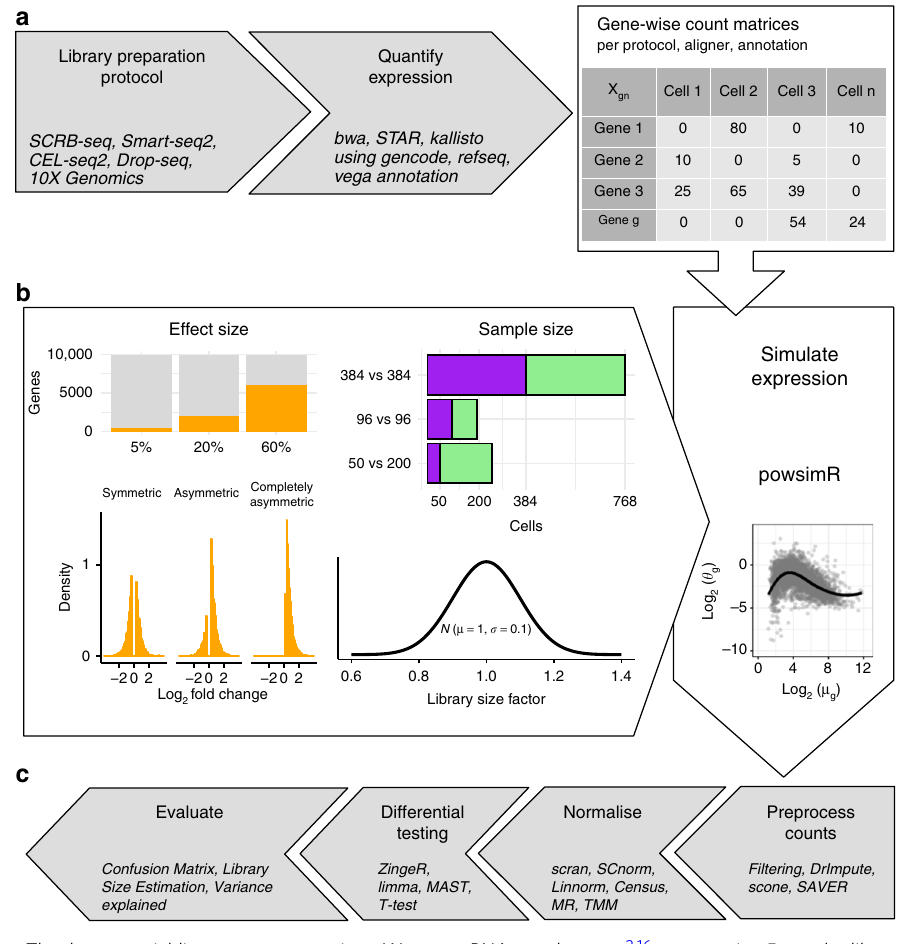
Fig. 1 Study Overview. a The data sets yielding raw count matrices: We use scRNA-seq data sets 2,16 representing 5 popular library preparation protocols. For each data set, we obtain multiple gene count matrices that result from various combinations of alignment methods and annotation schemes (see also Supplementary Figs. 1 and 2, and Supplementary Tables 1 and 2). b The simulation setup: Using powsimR 10 distribution estimates from real count matrices, we simulate the expression of 10,000 genes for two groups with 384 vs 384, 96 vs. 96 and 50 vs. 200 cells, where 5, 20 or 60% of genes are DE between groups. The magnitude of expression change for each gene is drawn from a narrow gamma distribution ( X ~ Γ ( α = 1, β = 2)) and the directions can either be symmetric, asymmetric or completely asymmetric. To introduce slight variation in expression capture, we draw a different size factor for each cell from a narrow normal distribution. c The analysis pipeline: The simulated data sets are then analysed using combinations of four count matrix preprocessing, seven normalisation and four DE approaches. The evaluation of these pipelines focuses on the outcome of the confusion matrix and its derivatives (TPR, FDR, pAUC, MCC), deviance in library size estimates (RMSE) and computational run